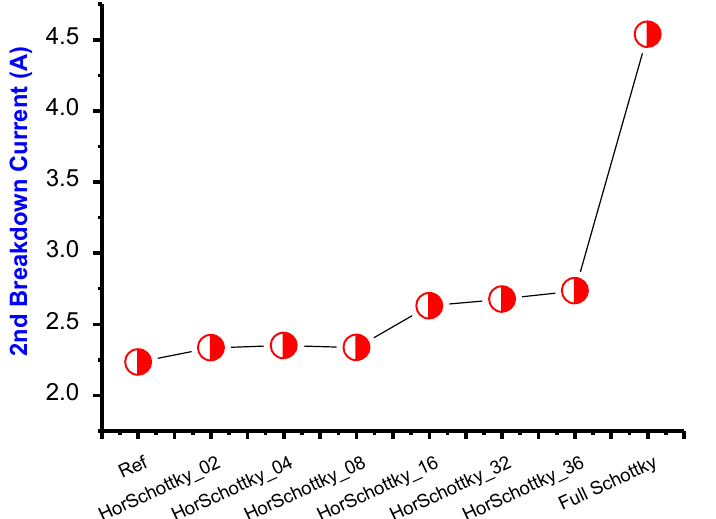
Figure 6. Trigger voltage and holding voltage distribution charts of HV nLDMOSs with the drain electrode-embedded horizontal Schottky rows modulation.